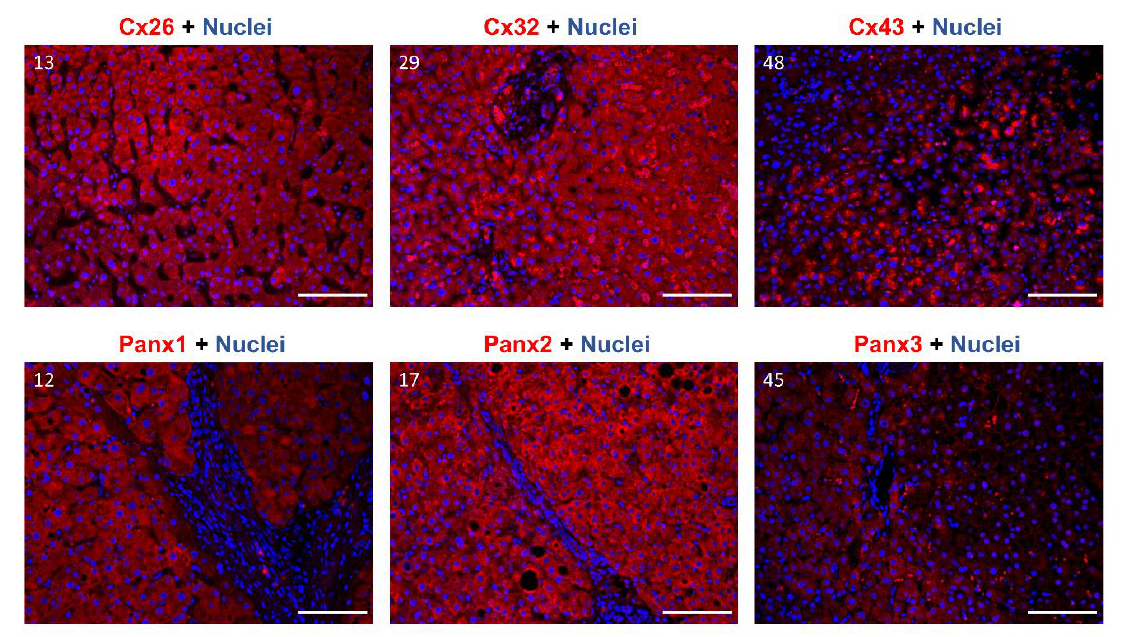
Figure 6: Cx26, Cx32, Cx43, Panx1, Panx2 and Panx3 protein localization in human liver samples. Samples were selected to undergo immunohistochemistry analysis based on the immunoblot results. Paraffin-embedded samples were sectioned into 5 μm thick sections. Cx26, Cx32, Cx43, Panx1, Panx2 and Panx3 are visualized in red, while the nuclei are counterstained in blue (DAPI). Detection was per- formed at 20× magnification. Scale bar = 100 µm. Sample numbers are indicated in the left upper corner of the